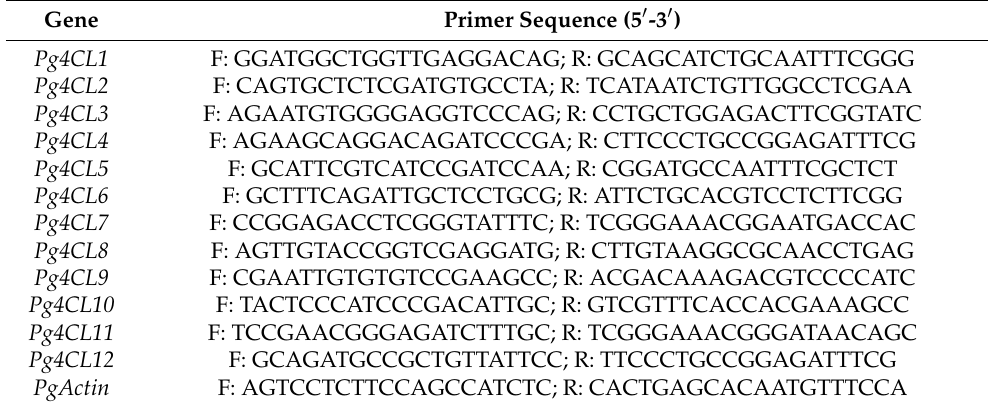
Table 4. Primers used in this